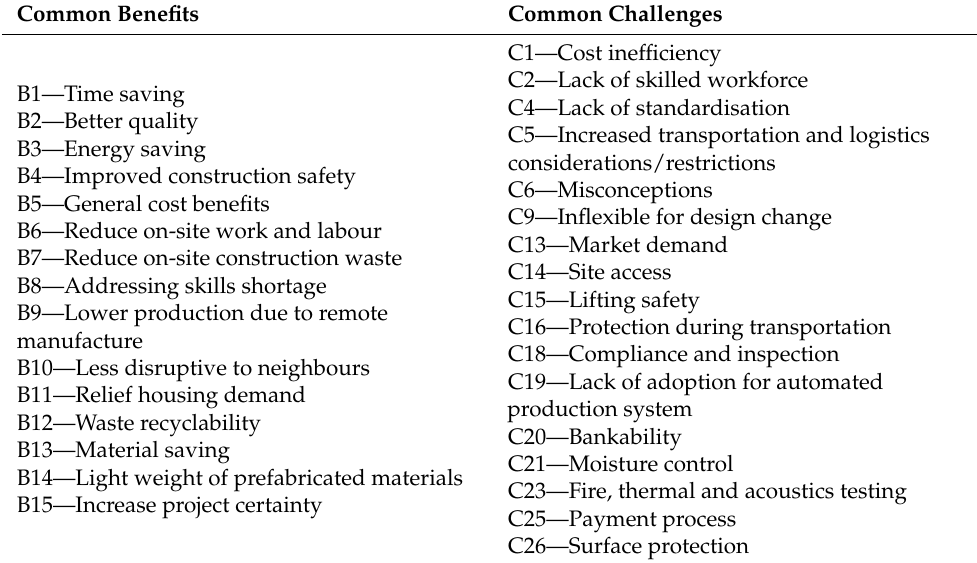
Table 5. Benefits and challenges shared by academia and industry